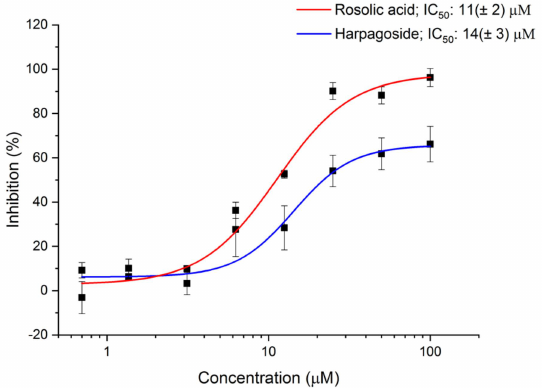
Figure 6. AI-2 QS inhibition by harpagoside and rosolic acid determined by AI-2 QS interference assay in the presence of PA β N. Data points represent means ± SD from two independent experiments ( n = 3). Only 100 µ M rosolic acid marginally a ff ected β -gal expression or activity in the control